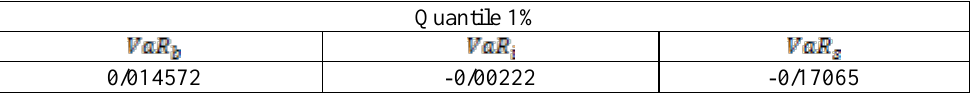
Table 3. Risk value of the three financial sectors of the bank, insurance and stock exchange